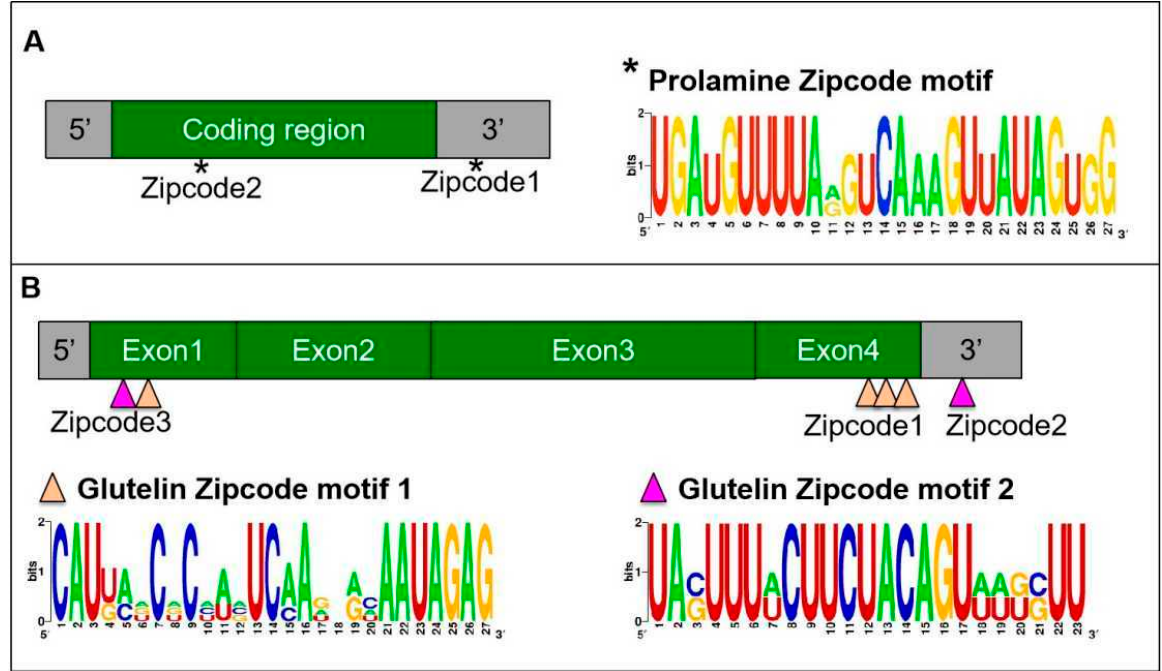
Figure 2. RNA zipcodes identified in prolamine ( A ) and glutelin ( B ) mRNAs (adapted from [34]). ( A ) The proximate locations ( left ) and the consensus motif sequence ( right ) of the two zipcode elements in prolamine mRNA. Prolamine zipcode elements are located in the coding region and 3 ′ UTR and consists of only a single zipcode motif (*). ( B ) The proximate locations ( top ) and the consensus motif sequences ( bottom ) of the zipcode elements in glutelin mRNA. Glutelin mRNAs possess three zip- codes (zipcode 1, 2, 3), which consist of two motifs, zipcode motif 1 (orange triangles) and zipcode motif 2 (magenta triangles). 5 ′ and 3 ′ denote 5 ′ UTR and 3 ′ UTR, respectively.